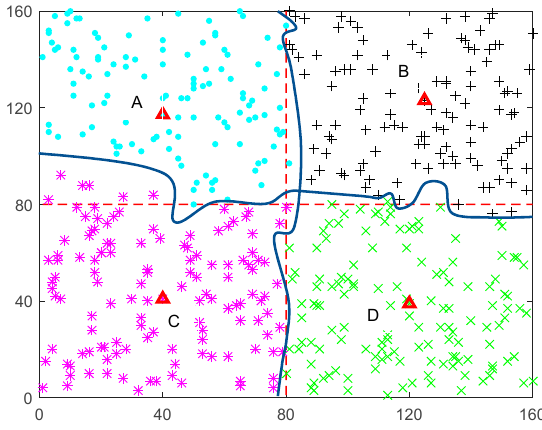
Figure 2. Network partition based on center points. 2